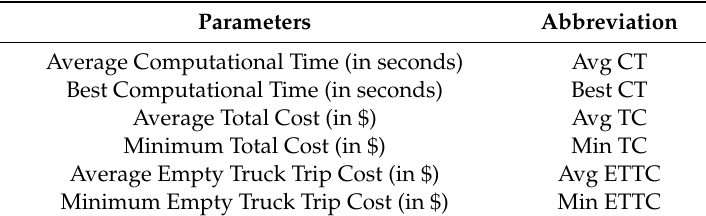
Table 7. Parameter abbreviations.